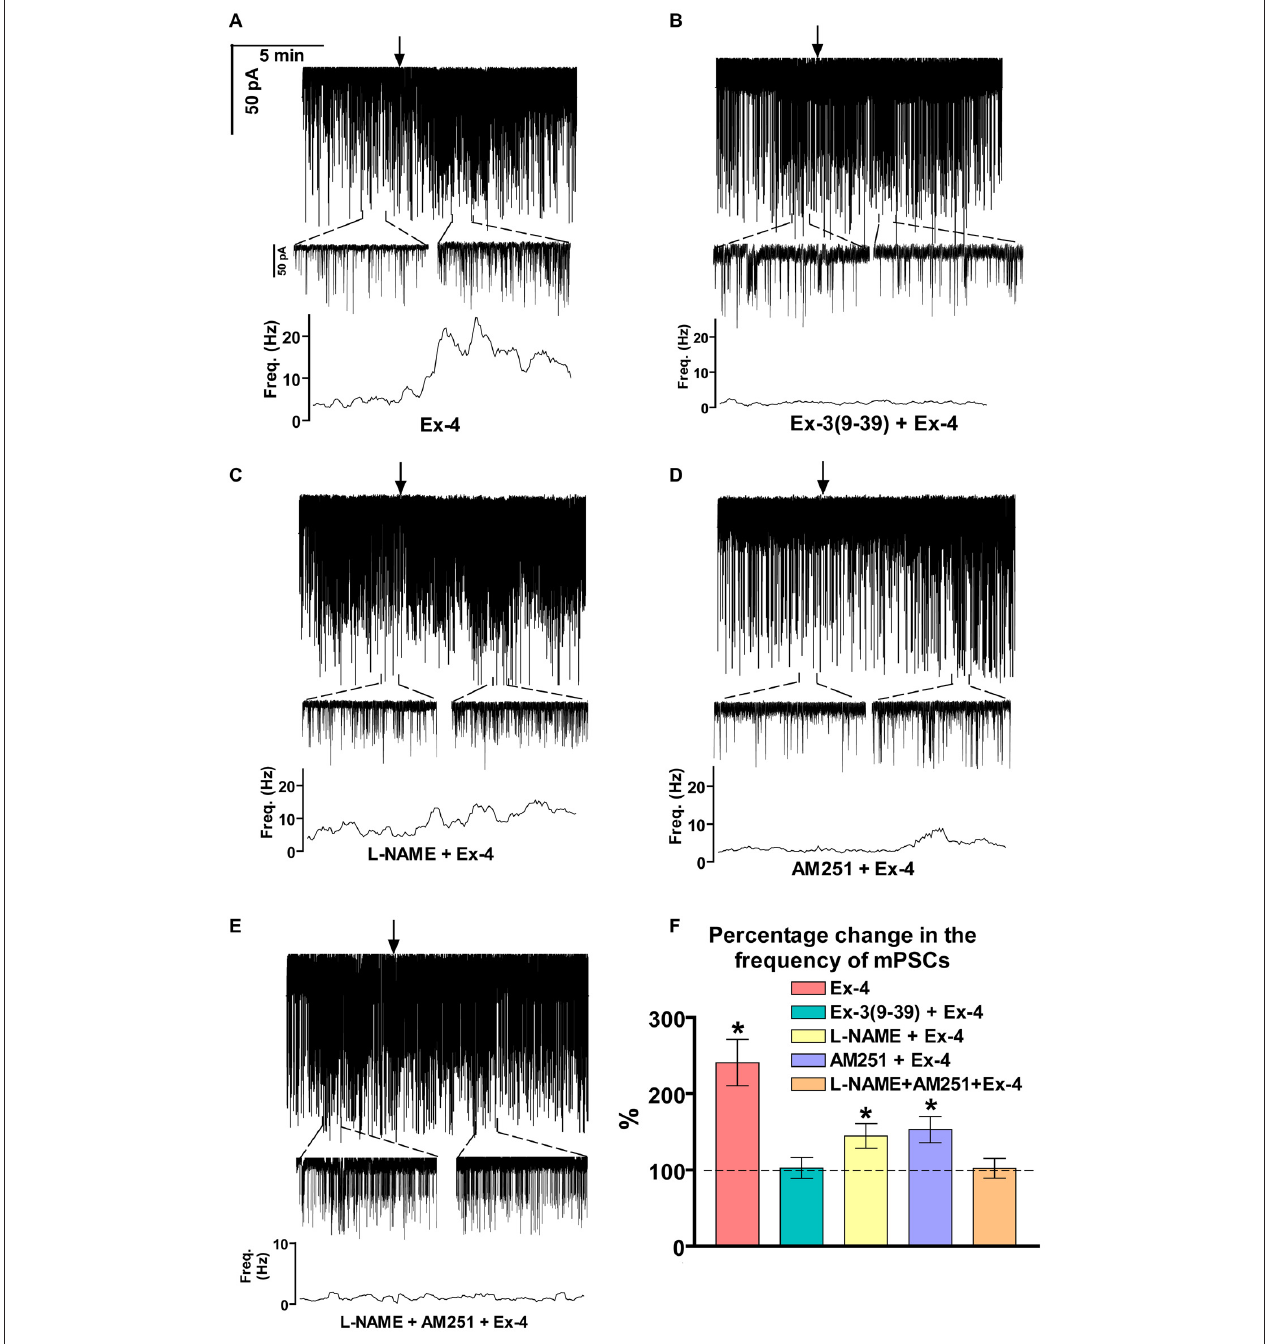
FIGURE 2 | Effect of Exendin-4 (1 µ M) on the miniature postsynaptic currents (mPSCs) in GnRH neurons of male mice. (A) Exendin-4 increased the frequency of the mPSCs with no change in the average amplitude. One-minute-long periods of the recording before and after application of Exendin-4 are drawn under the recording. The time course of frequency depicted under the zoomed periods shows change in the frequency. (B) Effect of Exendin-4 on the mPSCs was abolished by the pretreatment with Exendin-3(9–39). The zoomed periods and the frequency distribution graph confirm this observation. (C) Effect of Exendin-4 was eliminated only partially when the slice was pretreated with the nitric oxide-synthase (NOS) inhibitor N ω -Nitro-L-arginine methyl ester hydrochloride (L-NAME). (D) Similar partial inhibition was observed in the case of pretreatment with cannabinoid receptor type-1 (CB1) antagonist 1-(2, 4-dichlorophenyl)-5-(4- iodophenyl)-4-methyl-N-(1-piperidyl)pyrazole-3-carboxamide (AM251). (E) Full blockade could be accomplished by simultaneous blocking of the NO- and endocannabinoid signaling mechanisms. (F) Bar graph reveals that Exendin-4 significantly elevated the frequency of mPSCs. Full inhibition could be achieved by antagonizing the GLP-1R, whereas blockade of either the NO or the endocannabinoid system results in partial inhibition only. Arrows show the onset of Exendin-4 administration. ∗ p < 0.05.